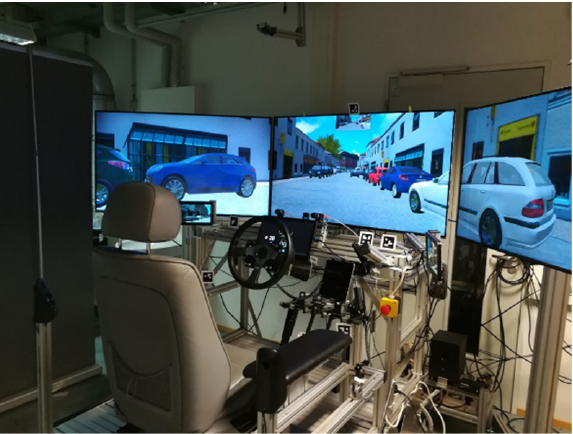
Figure 4. Mock-up with three 55 ″ ultra-HD monitors creating a 120° field of view, 13 ″ monitor for the IC, and tablet.